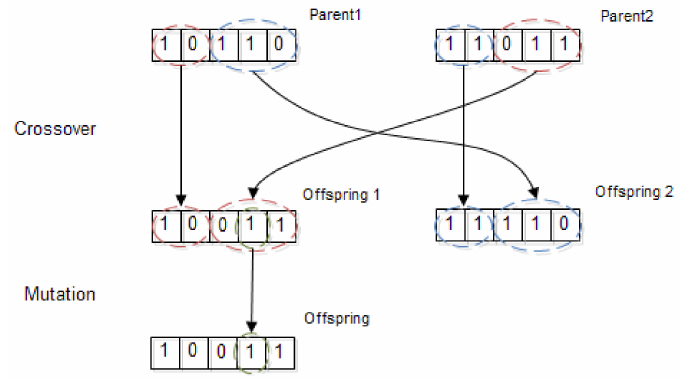
Figure 8. Crossover and mutation operators in GA.